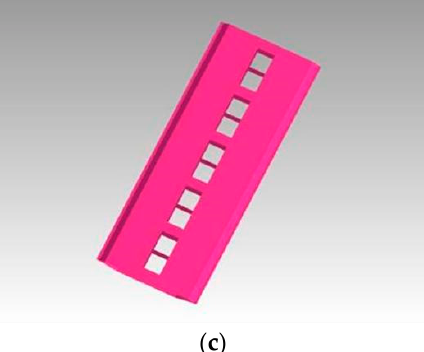
Figure 4. Dimension of numerical model. ( a ) Cross section of the numerical model (mm). ( b ) Top view of the bridge deck (mm) and the layout plan of pressure measuring section. ( c ) Effect drawing of numerical model.